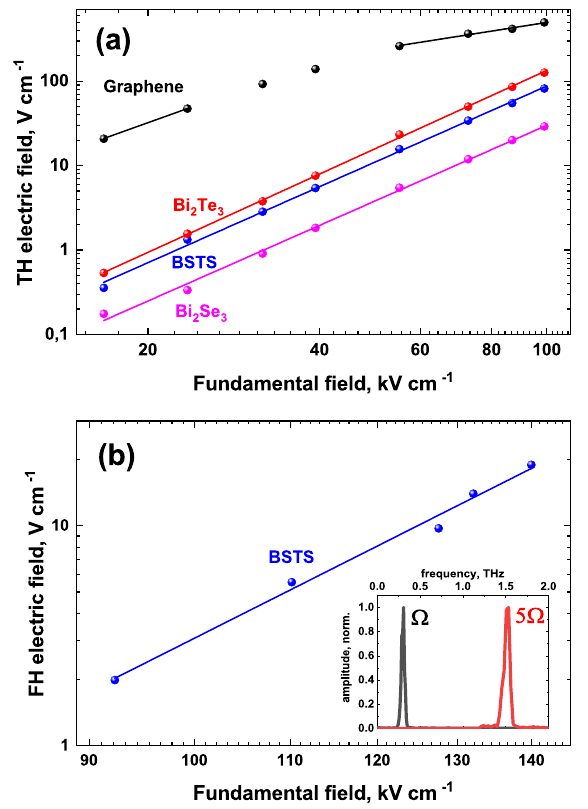
Fig. 3 Fluence dependence of the THz HHG. a The peak values of third-harmonic fi elds generated in topological insulators and graphene obtained for different driving fi elds of fundamental radiation at 500 GHz central frequency (dots). Solid lines are linear fi ts providing the scaling law: 1.06 ± 0.08 for graphene at highest fi eld and 2.3 at lowest fi elds, 3.08 ± 0.03 for Bi 2 Te 3 , 2.99 ± 0.06 for BSTS, and 2.98 ± 0.07 for Bi 2 Se 3 . b Fields of fi fth harmonic generated in BSTS, the slope of the linear fi t is 5.2 ± 0.3; The inset shows amplitude spectra of fundamental and fi fth from Bi 2 Te 3 at 1.5 THz (Fig. 2b) upon driving the sample with the 0.5 THz fundamental with a peak fi eld strength of 100 kV cm − 1 . In Fig. 2c the resulting amplitude spectra of the fundamental beam and the THG in both TI and substrate are shown. In these experiments, the THG polarization is collinear with the polarization of the linear fundamental beam polarization. The third-harmonic fi eld strength scales down linearly with fundamental beam ellipticity reaching zero in the case of circularly polarized pump (see Supplementary Figs. 5, 6). As we investigated the THz THG in transmission geometry, the observed harmonics can originate from both front (air – TI interface) and back surfaces (TI – substrate interface) of the sample. In Fig. 3a, we show the peak fi eld strengths of the third- harmonic signal generated in Bi 2 Se 3 , Bi 2 Te 3 and BSTS as a function of the fi eld strength of the fundamental radiation. For comparison we show THz third-harmonic signal measurements from p-doped graphene with around 10 13 cm − 2 charge carrier concentration. For fundamental fi eld strengths between 60 and 100 kV cm − 1 the third-harmonic signal from graphene exhibits clear saturation behavior and begins to scale linearly with the fundamental fi eld, rather than the expected cubic scaling for third-harmonic generation in the perturbative regime. Even in the lowest range of driving fi elds, between 15 and 25 kV cm − 1 , third-harmonic generation in graphene shows a power law scaling with an exponent of 2.3, indicating that the perturbative regime is only maintained at driving fi elds below 10 kV cm − 1 .